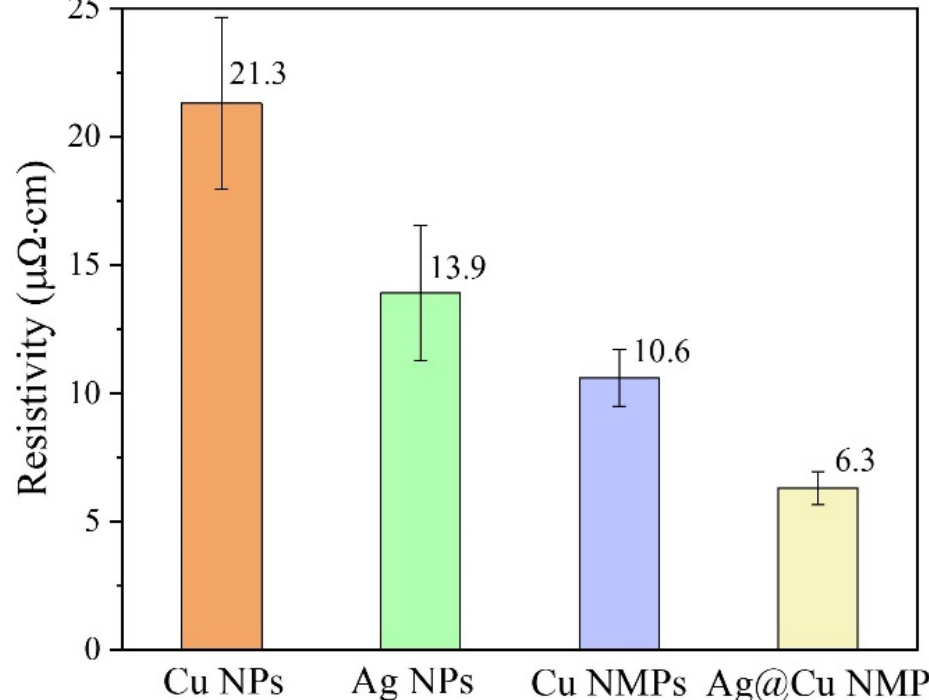
Figure 10. Electrical resistivities of the microvias filled with Cu NPs, Ag NPs, Cu NMPs and Cu@Ag NMPs at the sintering temperatures of 260 °C.